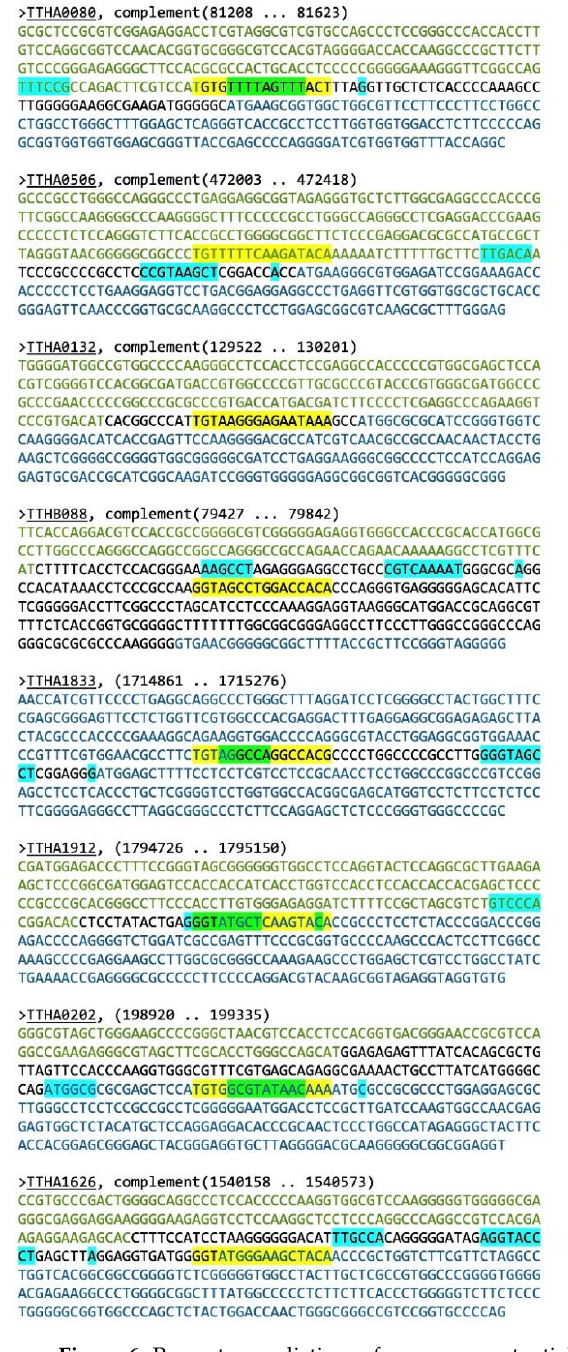
Figure 6. Promoter predictions of sequences potentially regulated by TTHB099 within the T. thermophilus HB8 genome. Shown are ± 200 bp sequences from the TTHB099 binding site identified through FIMO (see Table 2). Blue nucleotides represent the longest open reading frames with a downstream orientation relative to the TTHB099 binding site; Green nucleotides indicate open reading frames with the opposite orientation; Black nucleotides imply intergenic regions. Potential promoter elements ( − 35 and − 10 boxes, + 1 start site of transcription) are indicated with cyan highlighting; TTHB099-binding sites are indicated with yellow highlighting; Overlapping TTHB099-binding and core promoter elements are indicated by green highlighting.